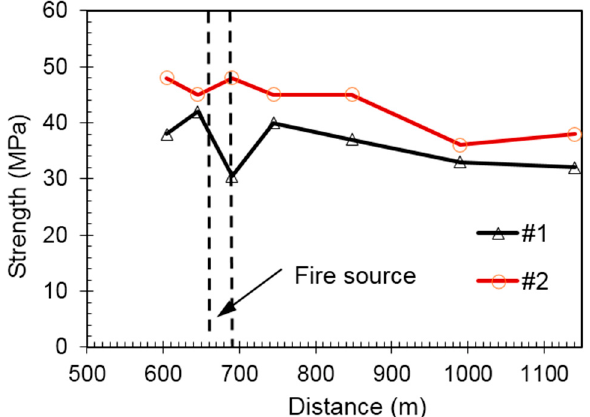
Figure 4. Comparison of compressive strength of #1 and #2 specimens at varied side wall locations.